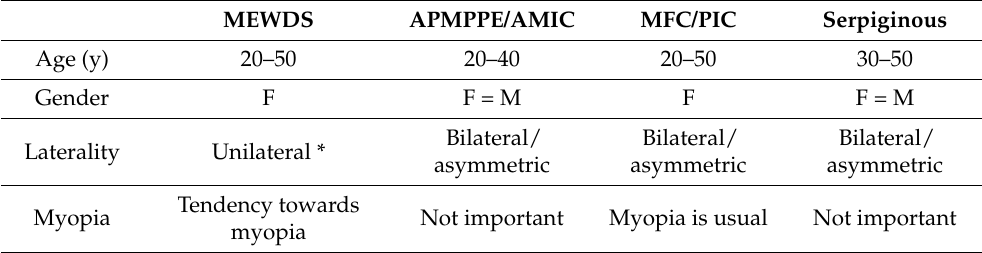
Table 1. Clinical and demographic data of